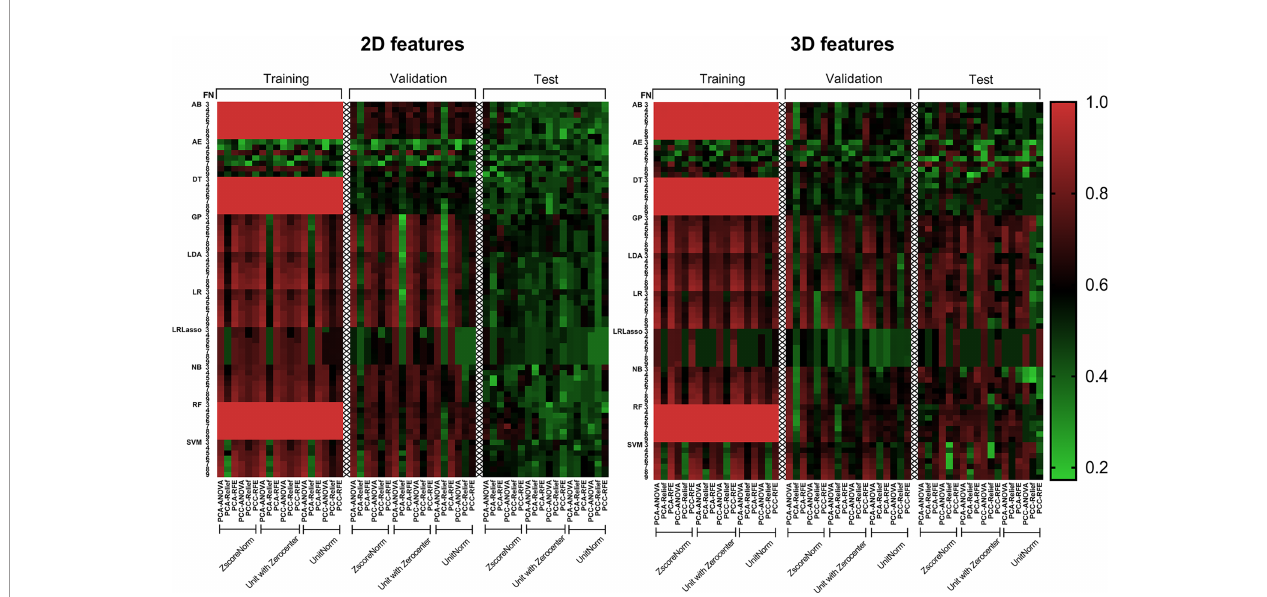
FIGURE 4 | AUC heat map in each dataset showed the performance of 2D and 3D features combined with different machine learning methods in distinguishing solitary pulmonary lesions. It can be clearly seen that the 3D feature group has much more machine learning combinations with higher AUC than 2D feature group in the test dataset. AB, Adaboost; AE, auto-encoder; ANOVA, analysis of variance; DT, decision tree; FN, feature numbers; GP, Gaussian process; LASSO, least absolute shrinkage and selection operator; LDA, linear discriminant analysis; LR, logistic regression; NB, naive Bayes; PCA, principal component analysis; PCC, Pearson correlation coef fi cient; RF, random forest; RFE, recursive feature elimination; SVM, support vector machine; Unitnorm, Min-max Normalization; Unit with Zerocenter, Mean Normalization; Zscorenorm, Z -score normalization.